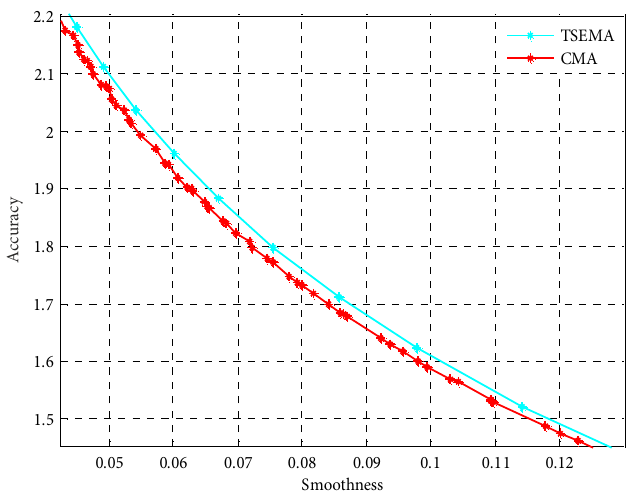
Fig. 9. Smoothness vs. Accuracy of CMA and TSEMA